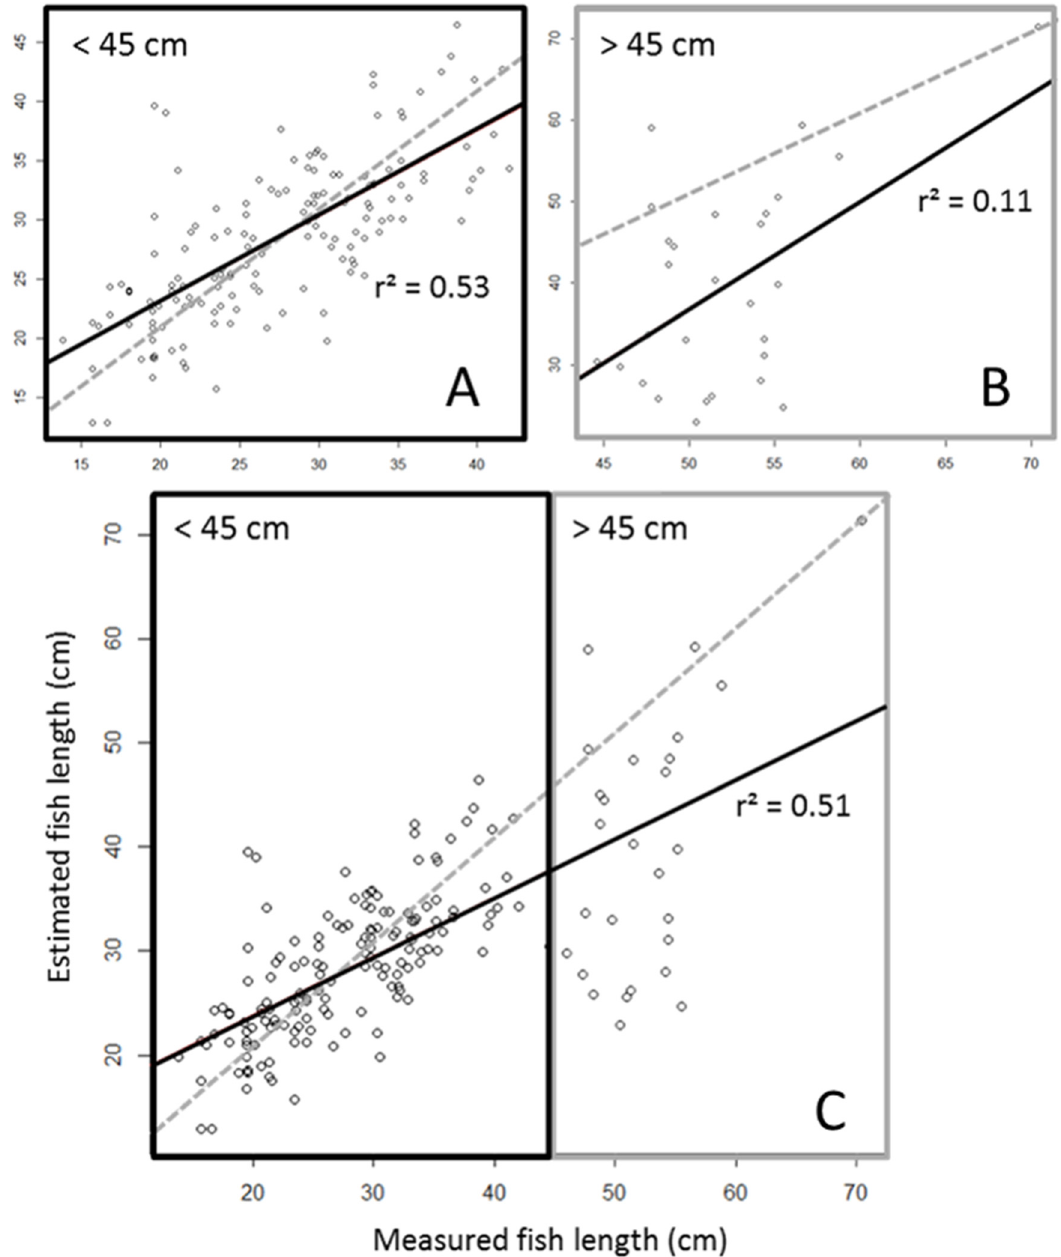
Fig. 7. Correlation between fi sh length estimated by the Sonar5-Pro tool and fi sh length measured manually using SMC software for (A) fi sh < 45 cm ( n =152); (B) fi sh > 45 cm ( n =27); (C) all the fi sh (n= 179). Grey dashed lines represent 1:1